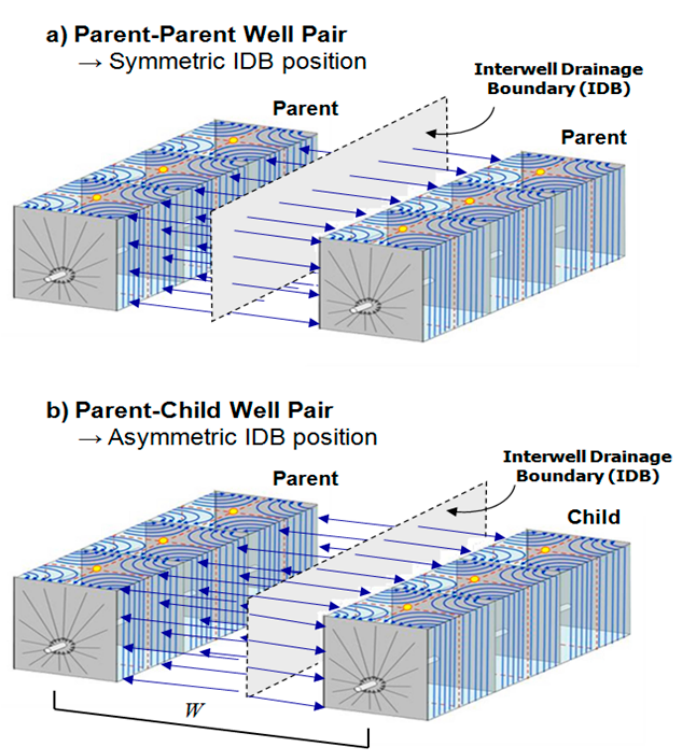
Figure 12. Position of the Inter-well Drainage Boundary (IDB). ( a ) Parent-parent well-pair. ( b ) Parent-child well-pair, with the onset of production of the child well at time t 1 (after Weijermars et al. [9]). Table 6. Key reservoir properties assumed in di ff usivity equations (adapted from Reference [13]). Physical Quantity Magnitude